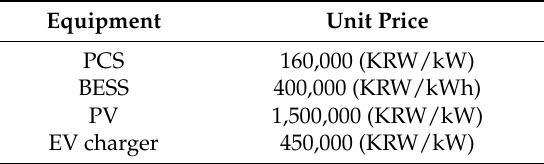
Table 6. Unit prices of